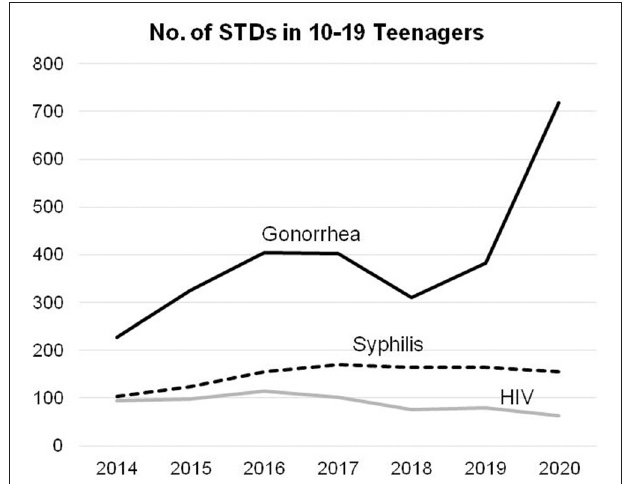
FIGURE 2 | Teenage infections of syphilis, gonorrhea, and HIV during 2014–2020 in